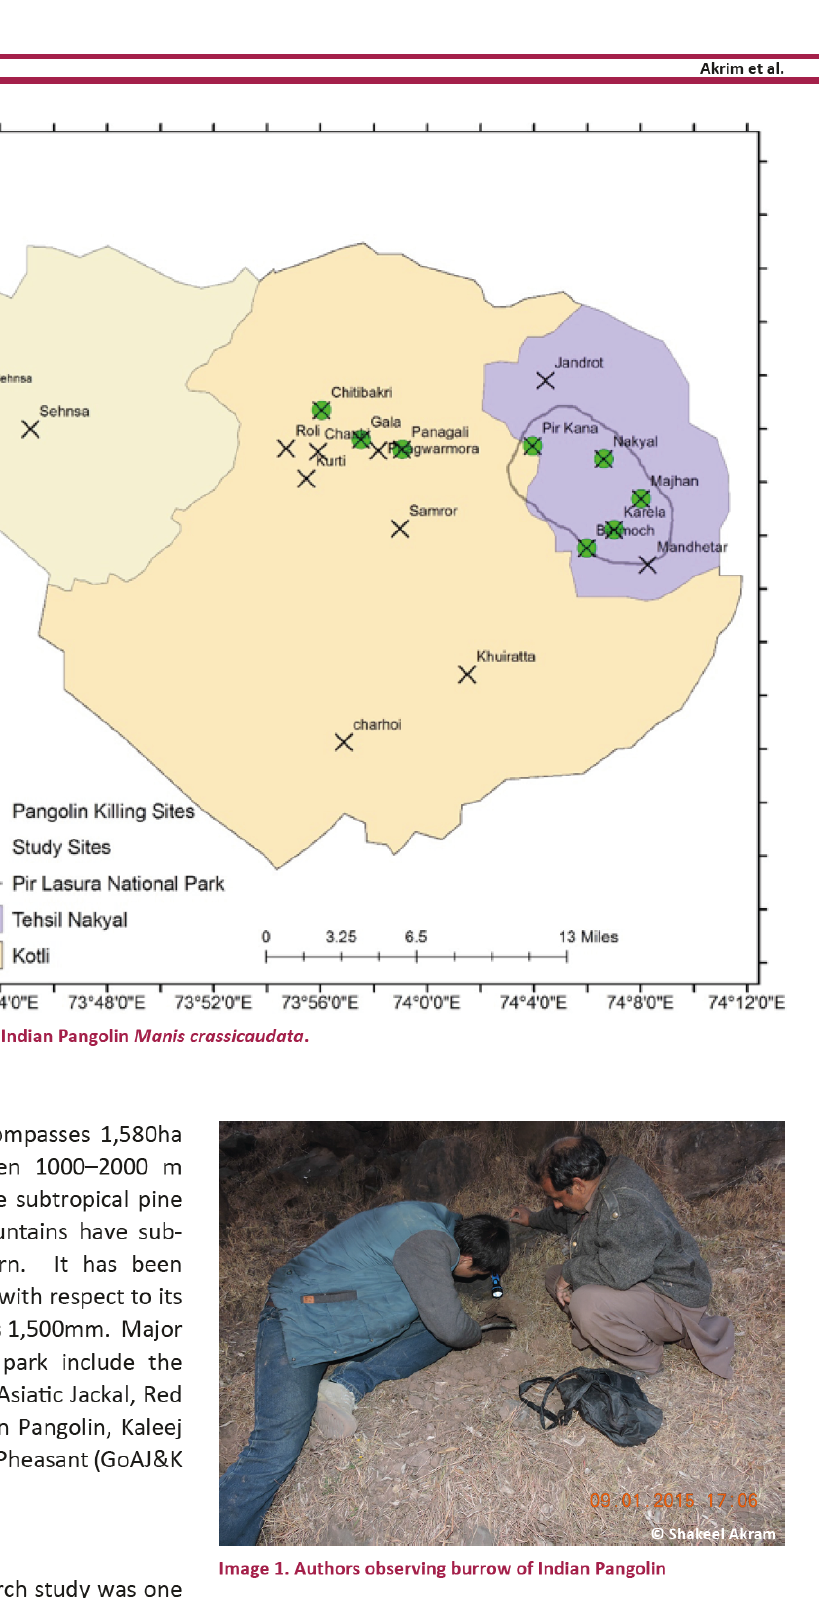
Image 1. Autthors observfing burrow of Indfian Pangolfin